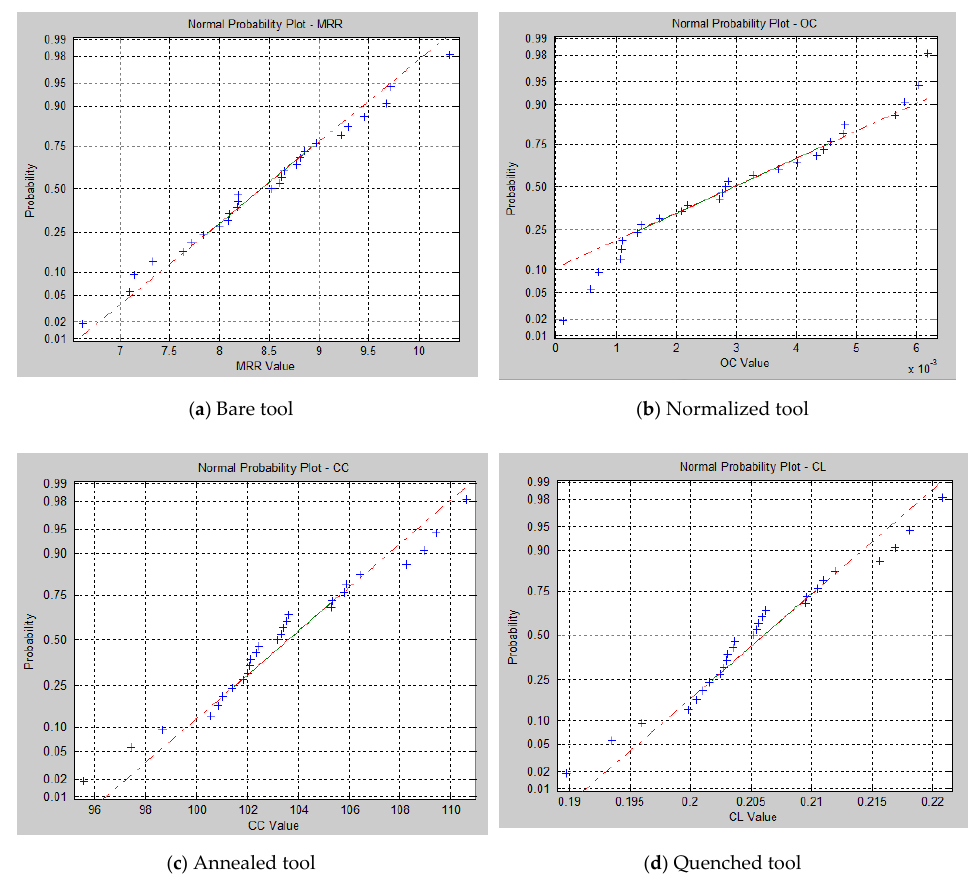
Figure 10. Normal probability plot for response values. ( a ) Bare tool; ( b ) Normalized tool; ( c ) An- nealed tool; ( d ) Quenched tool.